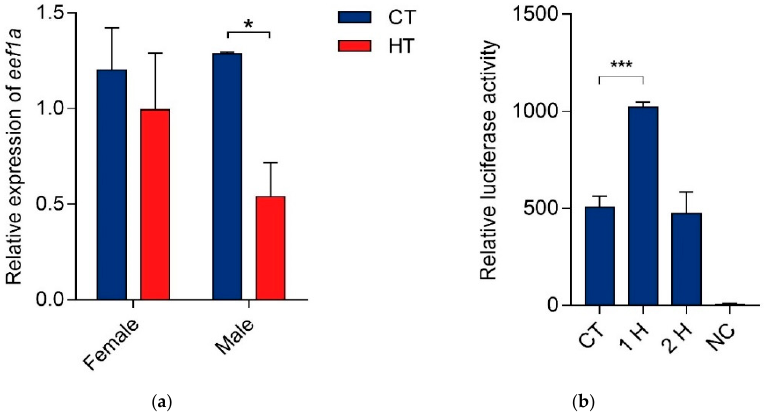
Figure 5. eef1a1 expression patterns under high temperature: ( a ) Gonadal eef1a1 expression patterns in C. semilaevis cultured under high temperature and normal temperature from 30 dpf to 3 mpf. Relative expression levels at 3 mpf were presented as mean ± S.E.M. ( n = 3). CT: control temperature (22 °C); HT: high temperature (28 °C). ( b ) C. semilaevis eef1a1 promoter activity analysis under high temperature. Luciferase activities were shown as mean ± SEM ( n = 3). CT: control temperature (37 °C); 1 H: high temperature (42 °C) treated for 1 h; 2 H: high temperature treated for 2 h; NC: pGL3- Basic as negative control. Asterisks represented statistically significant difference (*, p < 0.05; ***, p < 0.001). 3.6. eef1a1 Can Response to High Temperature Rapidly To evaluate if eef1a1 can respond to environmental high temperature, the eef1a1 pro- moter sequence of 1630 bp upstream from the start codon was cloned for activity analysis. The 293T cell was then transfected with peef1a1-luc reconstructed vector. After high tem- perature (42 °C) treatment for 1 h, the eef1a1 promoter activity increased rapidly to 2.028 times that of the control group ( p < 0.05), and then returned to the nearly normal level after 2 h treatment (Figure 5b). These results suggested that eef1a1 can respond rapidly to high temperature. 4. Discussion In the present study, the eef1a1 gene from C. semilaevis was isolated and its complete sequence was characterized. The deduced eEF1A1 protein consisted of 461 amino acids and possessed a conserved EF-1_alpha domain. The extremely high identity between the C. semilaevis eEF1A1 and homologues from other species indicated the structural conser- vation of this polypeptide during vertebrate evolution, which may be owed to its essential role in the core biological process of protein translation. Based on the expression analyses, eef1a1 was highly abundant and exhibited a wide distribution in different tissues in adult C. semilaevis . This tissue distribution pattern was consistent with eef1a1 in other teleosts and mammals [21–23], which further supported that the transcript cloned in this study was the definite isoform. It is worth noting that eef1a1 was expressed relatively high in the gonad, with a statistical female-biased sexual dimorphism. The expression level of eef1a1 peaked at 6 mpf, and remained high in the adult ovary. Previous research has reported that C. semilaevis finished gonadal differenti- ation and went on to develop at 6 mpf, which was followed by an important period for ovum development and yolk energy reserve [24]. Thus, this expression pattern of eef1a1 may be related to its role in protein synthesis, and eef1a1 may play a vital role during gonadal development.